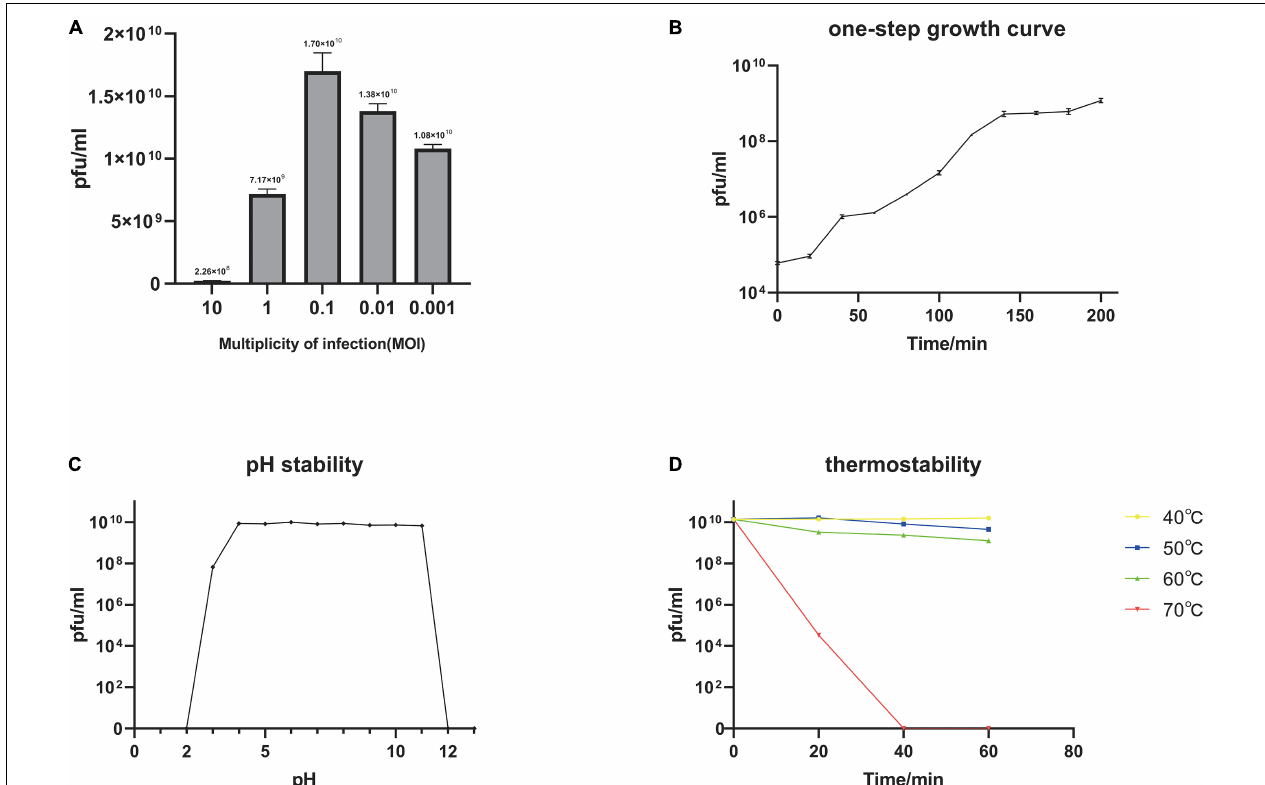
FIGURE 2 | Biological characterization of the phage BUCT549. (A) The MOI test of BUCT549. (B) The one-step growth curve of phage BUCT549, and data points show phage titers measured at 20-min intervals. (C) pH stability of BUCT549, and data points are phage titers measured after incubation of phage at different pH for 1 h. (D) Thermostability curve of BUCT549, and data points are phage titers measured after incubating the phage at different temperatures for 20, 40, and 60 min, respectively. All assays were performed in triplicate.